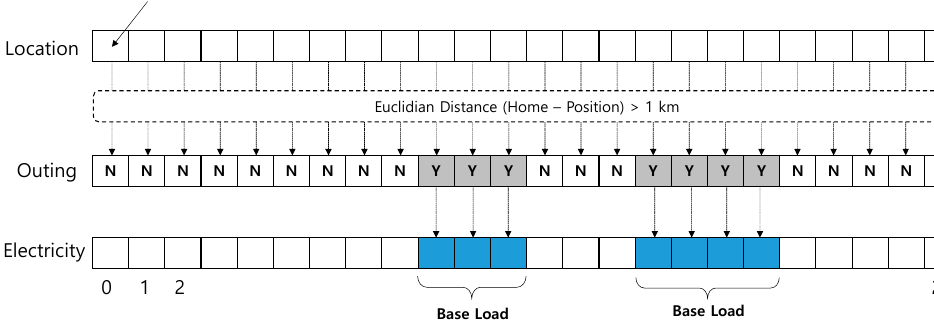
Figure 4. Method of finding base load.